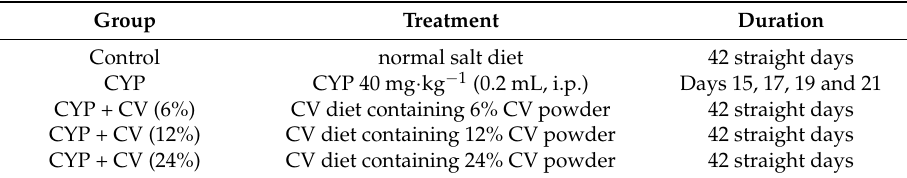
Table 2. Mice of each group with various